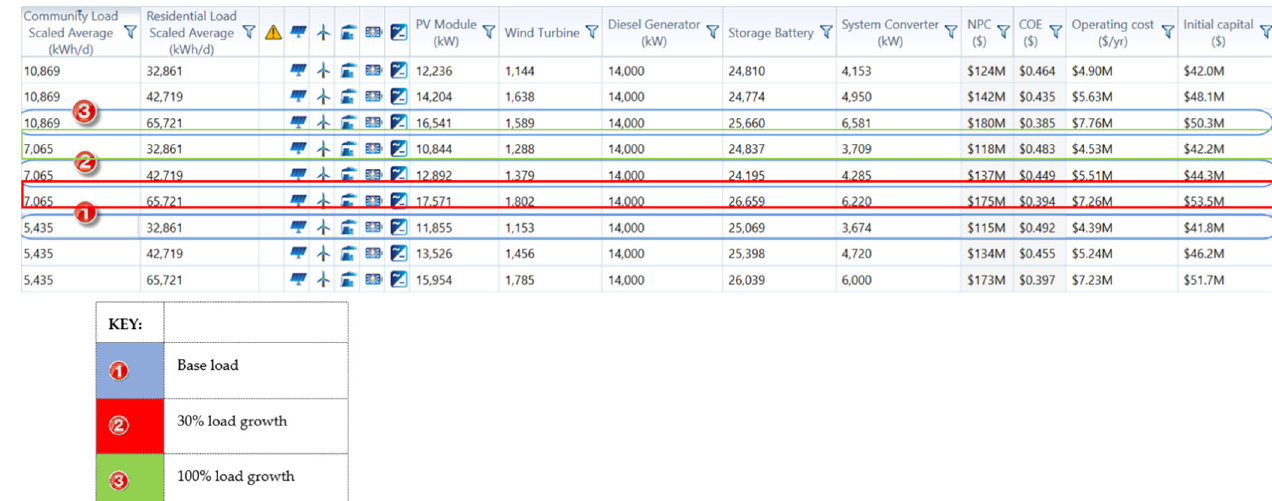
Figure 17. Impact of load growth on system costs.